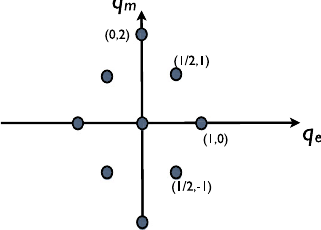
FIG. 2. Charge-monopole lattice at θ ¼ n π with